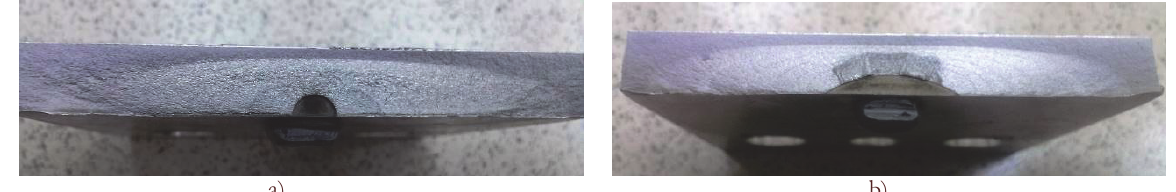
Figure 3: Surface crack paths under bending for initial aspect ratio (a) (a/c) 0 =1.0 and (b) (a/c) 0